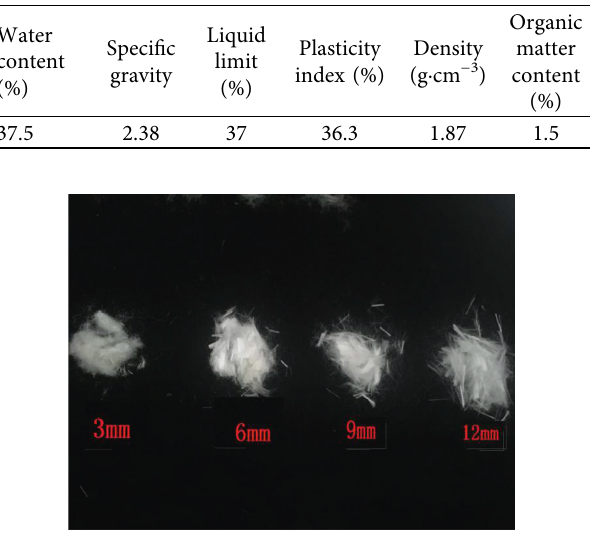
Figure 1: Polyvinyl alcohol